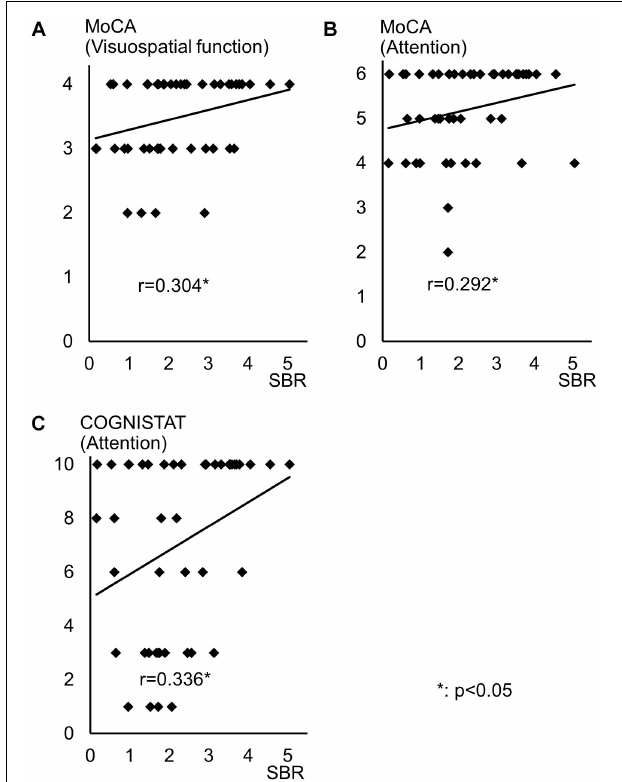
FIGURE 3 | Distribution of SBR and scores for cognitive assessments with significant Spearman correlation coefficients. Distribution of SBR of 123 I-Ioflupane SPECT with MoCA subscore of (A) visuospatial function and (B) attention, and (C) COGNISTAT attention subtest.